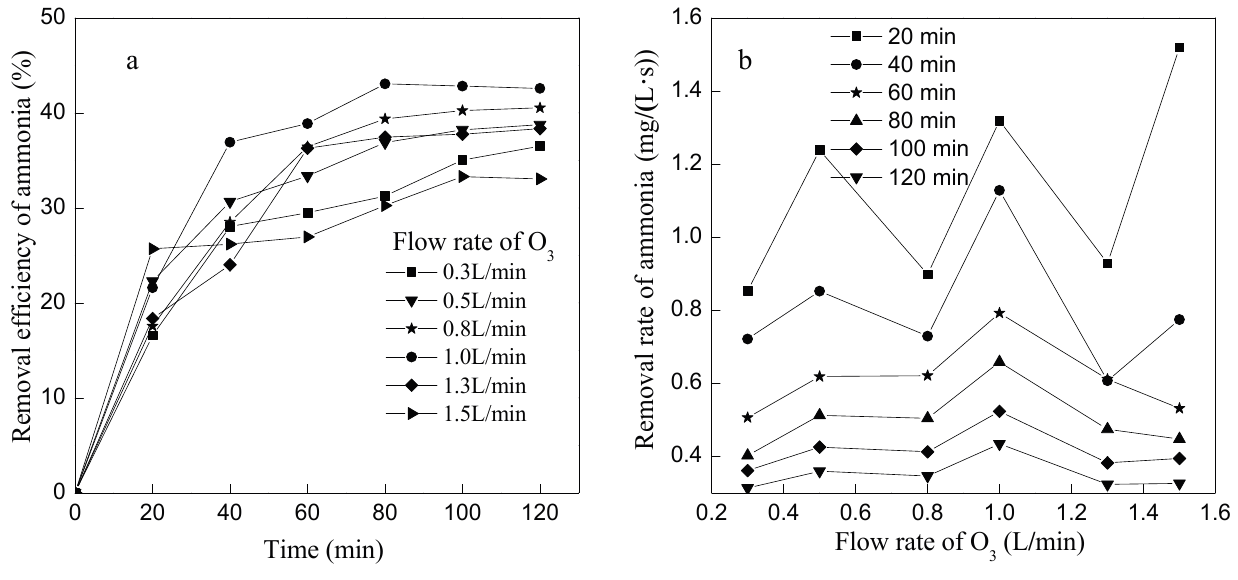
Figure 3. Effect of ozone flow rate on ammonia removal. ( a ) The effect of ozone flow rate on removal efficiency of ammonia; ( b ) The effect of ozone flow rate on removal rate of